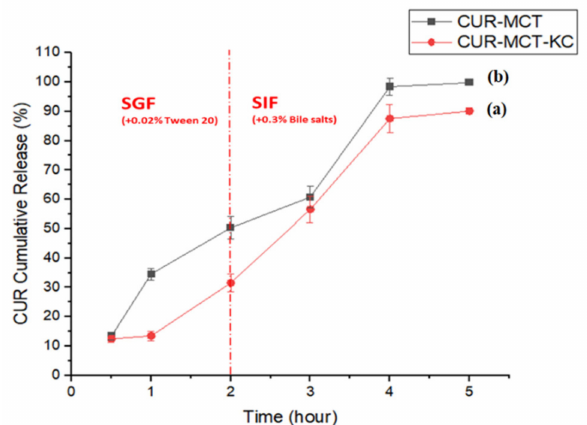
Figure 9. Cumulative in vitro drug release profile of CUR from ( a ) CUR-loaded-MCT-KC beads and ( b ) CUR-MCT emulsions at 37 ◦ C with gentle shaking, 150 rpm in SGF (pH 1.2) for 2 h incubation and followed by the subsequent 3 h incubation in SIF (pH